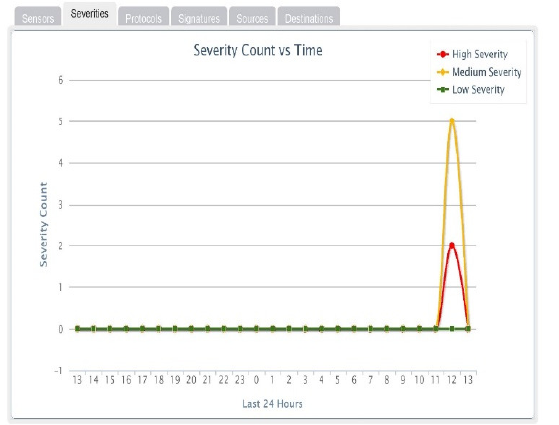
Fig. 20: Attacks severities level